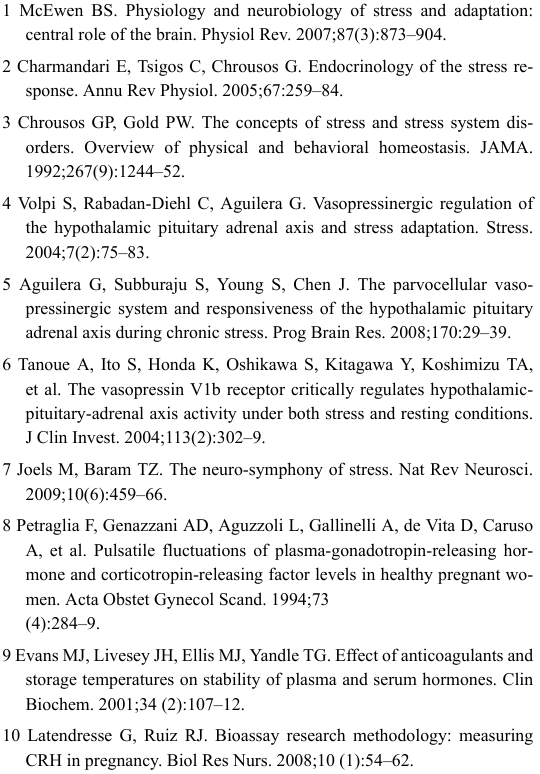
Table 2 Copeptin levels in different diseases. Disease Median Copeptin pmol/l (range) Ischaemic stroke Acute myocardial infarction Heart failure